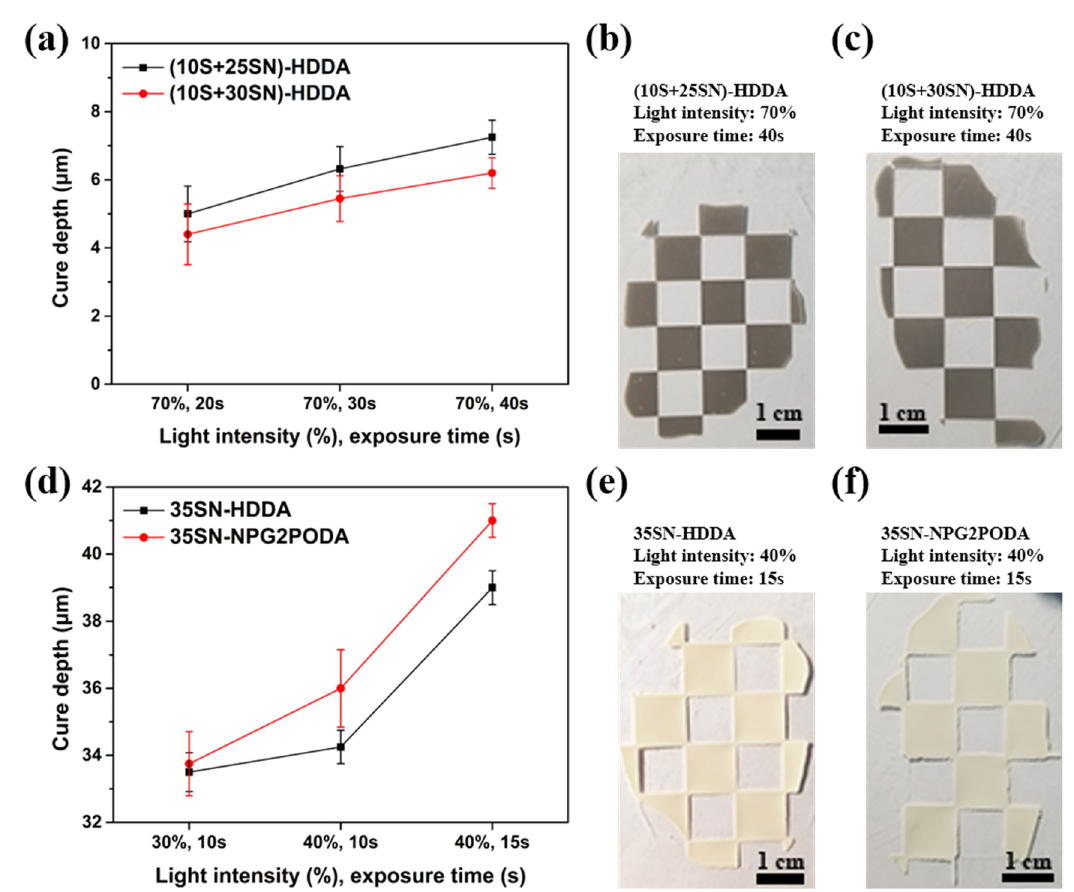
Figure 7. ( a ) Cure depth vs. exposure parameters for (10S + 25SN)-HDDA and (10S + 30SN)-HDDA slurries with their respective optical pictures (( b , c ), light intensity: 70%, exposure time: 40s, energy density: 1.61 J/cm 2 ). ( d ) Cure depth vs. exposure parameters for 35SN-HDDA and 35SN-NPG2PODA slurries with their respective optical pictures (( e , f ), light intensity: 40%, exposure time: 15s, energy density: 0.35 J/cm 2 ).